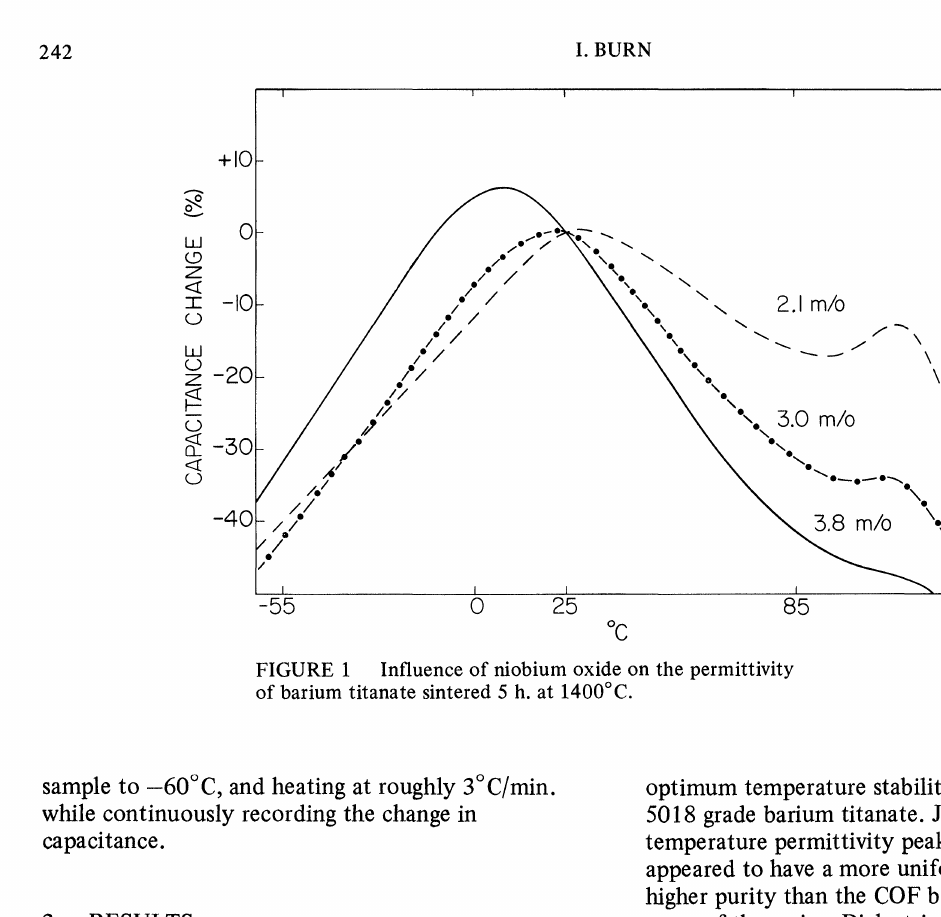
sample to -60C, and heating at roughly 3C/min.